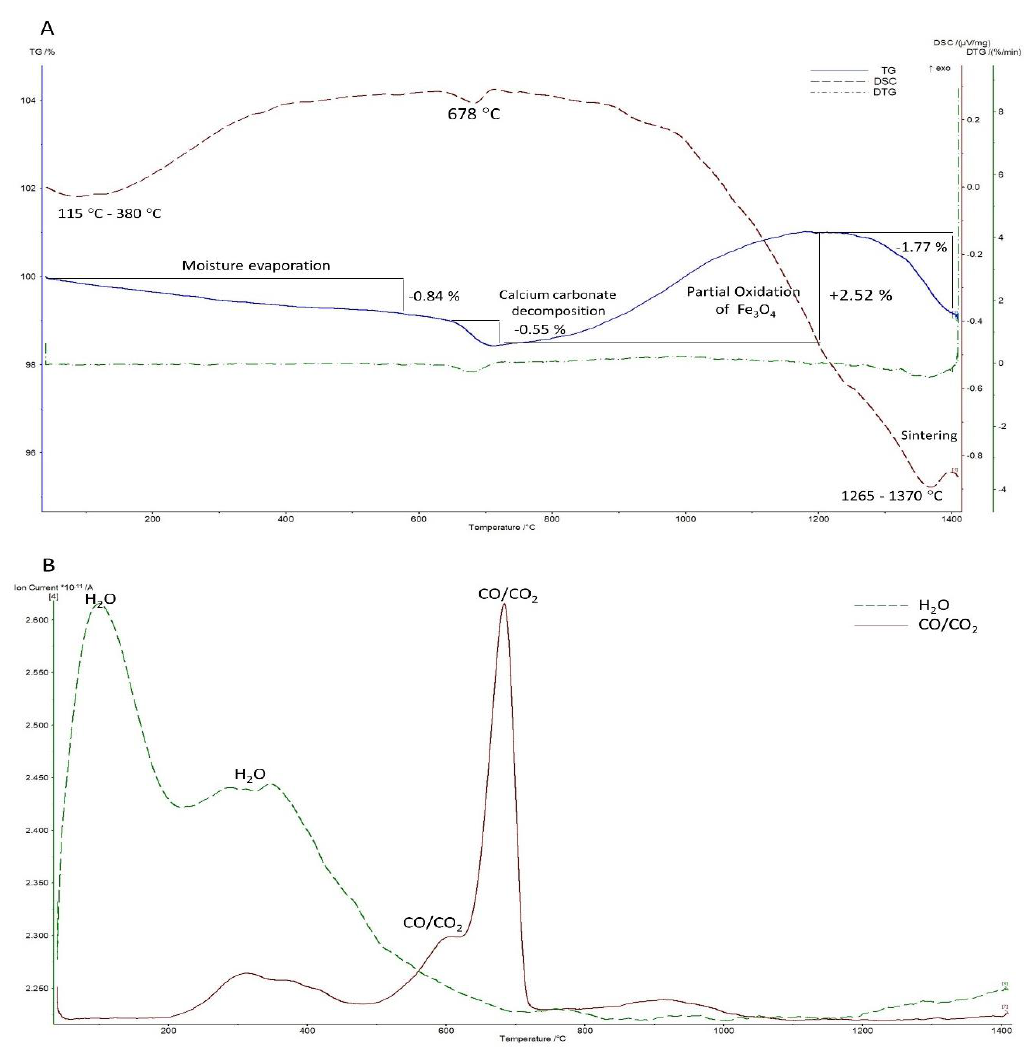
Figure 3. Thermal analysis of BOF sludge under air atmosphere: ( A ) TG / DTA / DTG; ( B ) Mass spectroscopy.